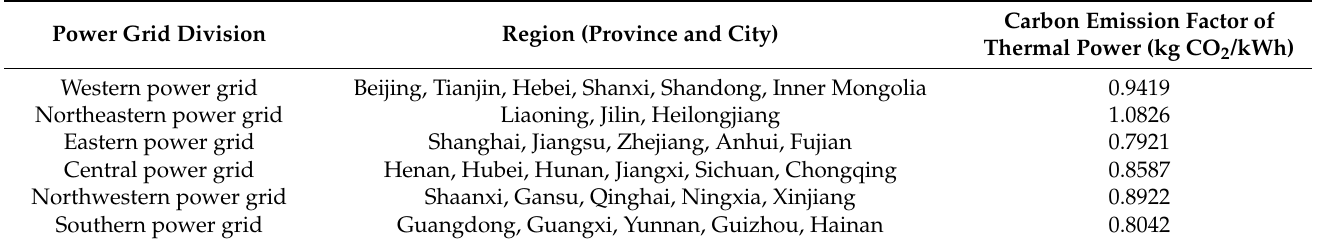
Table A6. Carbon emission factors of thermal power in different regions.